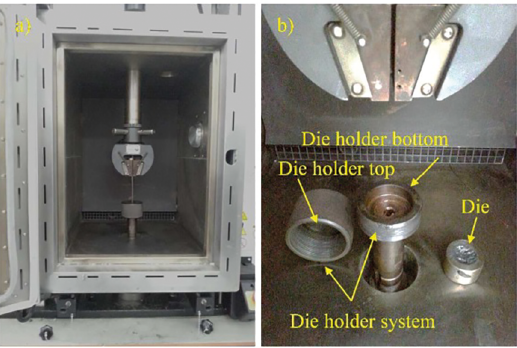
Figure 1. Wire drawing test: a) overall view of wire drawing apparatus inside the environmental chamber. b) details of the die